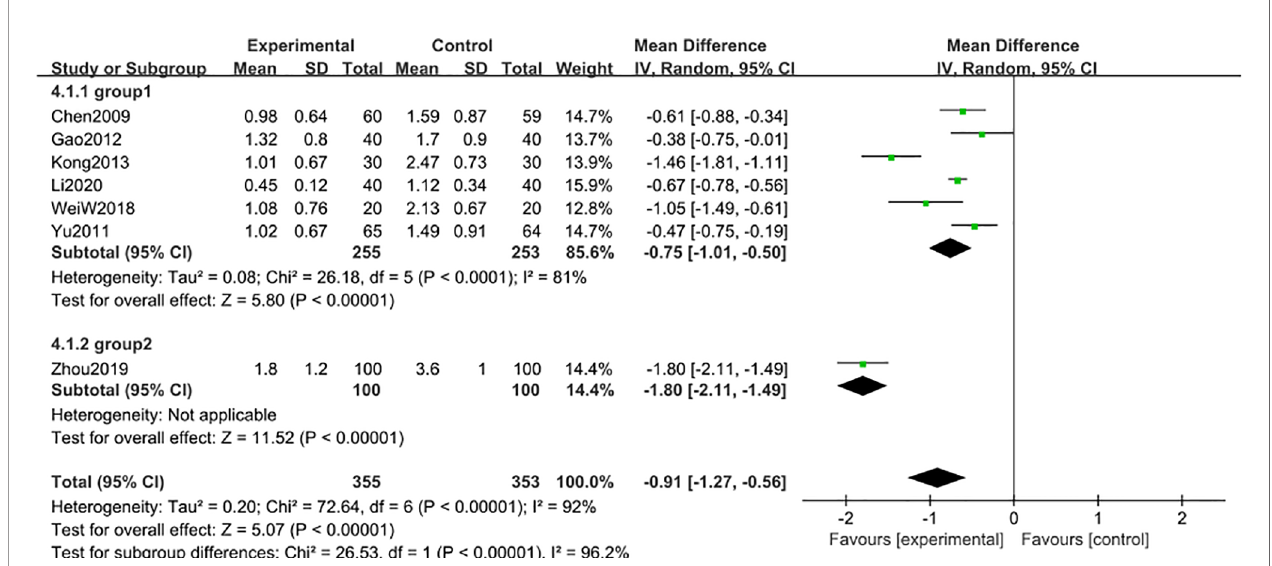
FIGURE 8 | Subgroup analysis of 24 h-UTP level after 6 months: comparison of treatment combined with TG against basic treatment (group 1: range 2-3 g, group 2: range 4-5 g).